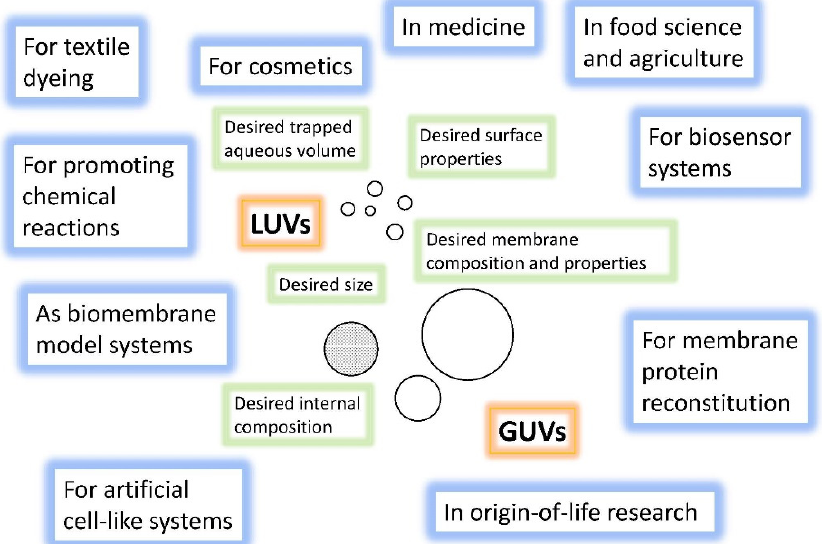
Figure 26. Some of the areas where lipid vesicles are used, either in commercial products, for preclinical or clinical studies (as LUV dispersions), or as tools for fundamental studies in research laboratories (LUVs or GUVs). Depending on the application, the size and properties of the vesicles can be tuned; see Chapters 4 and 5.